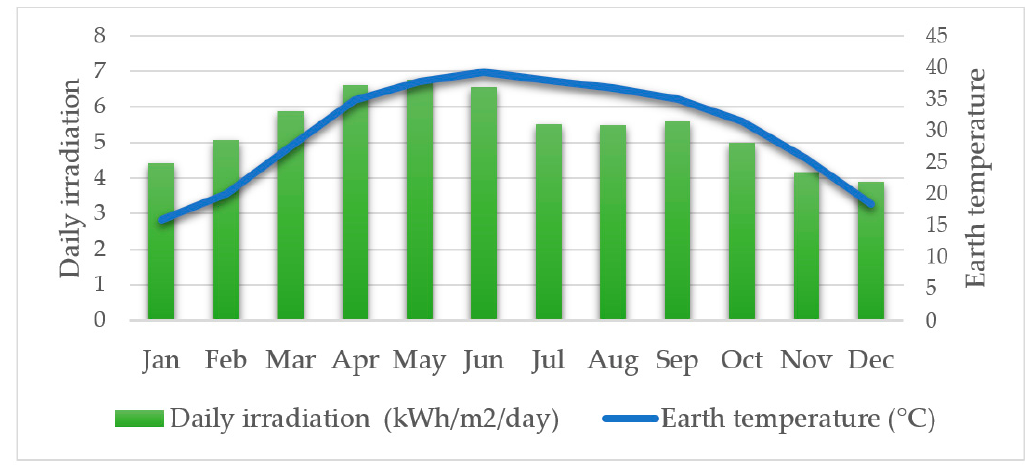
Figure 6. The Mirpurkhas region daily solar irradiation received.